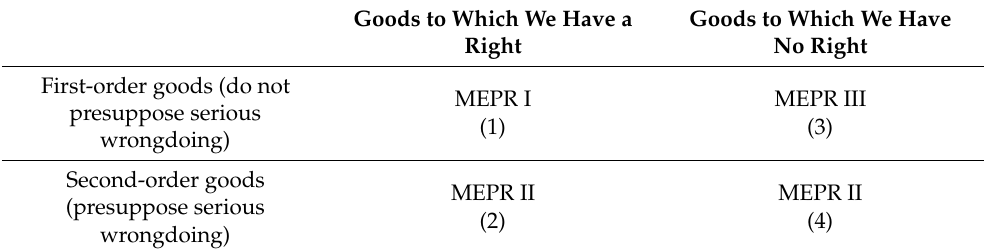
Table 1. Rights to Goods and Types of